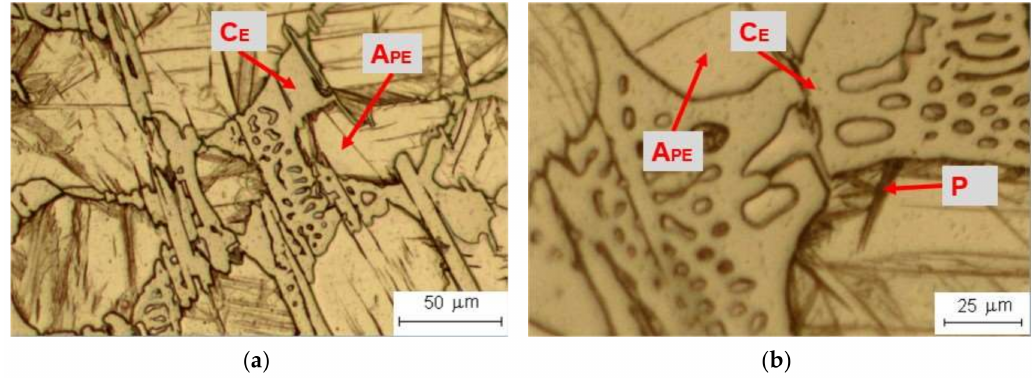
Figure 2. Marshall reagent for 25 s at room temperature: ( a ) general view at 200 × ;( b ) detail at 500 ×